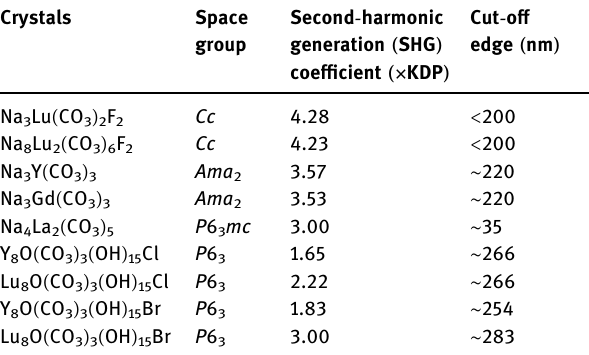
Table 1: Optical properties of alkali metal - rare earth carbonate crystals Crystals Space